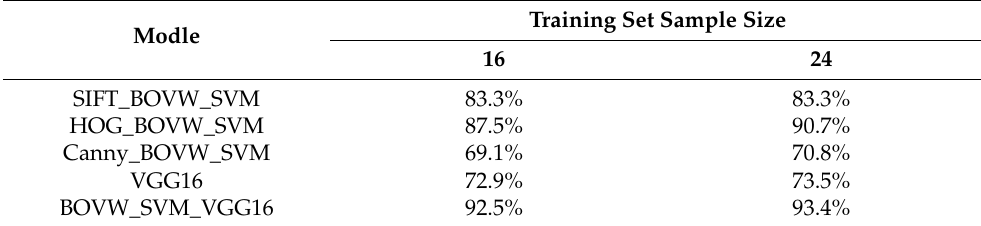
Table 4. Classification accuracy under small label samples of different